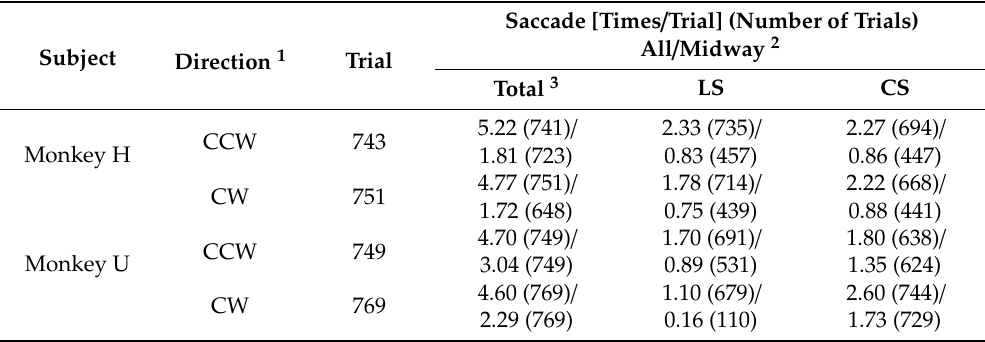
Figure 5. Two types of saccades during the circle-drawing task are depicted. ( A ) Example trials of the circle-drawing task from the 315° start point toward the clockwise direction in Monkey H . ( B ) Distributions of gaze points directed by saccades relative to the hand position are shown. Broken lines indicate the borders (–35° and 35°) of LS, CS, and other saccades. ( C ) Distributions of gaze points directed by LS, CS, and the other saccade are plotted in relation to a start point (a positive sign is assigned to the phase when the gaze point is in the cursor movement direction). Bin width is 5° in all the panels. Table 2. Occurrence probability of each type of saccades during the circle-drawing task.